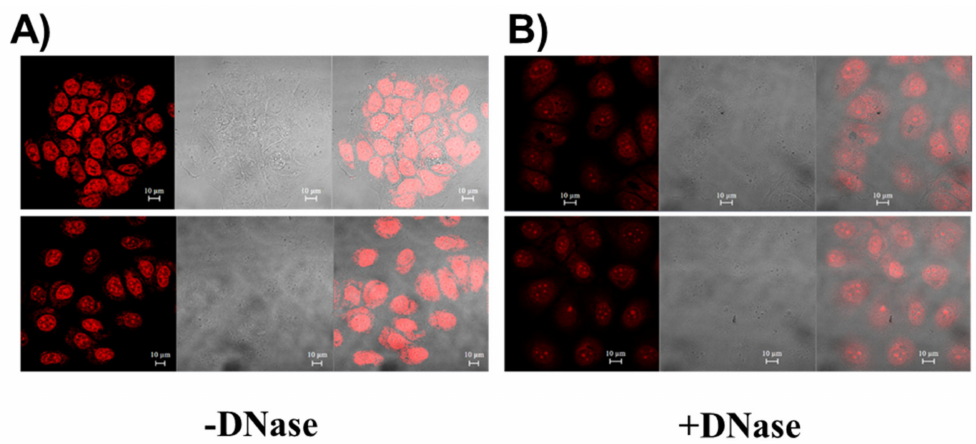
Figure 11. Binding of c ex -NDI to intracellular DNA of MCF7 cells. Cells were incubated with 1.25 µ M c ex -NDI for 6 h and ( A ) fixed or ( B ) fixed and treated with 200 U of